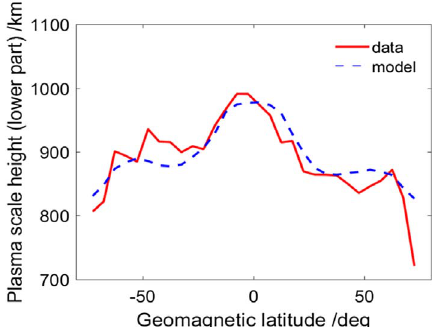
Fig. 21. Plasmaspheric scale height H Ph derived from observations (red line) and represented by the NPSM (dashed blue line) published by Jakowski & Hoque (2018). Further details concerning observa- tional data and the model can be found in that